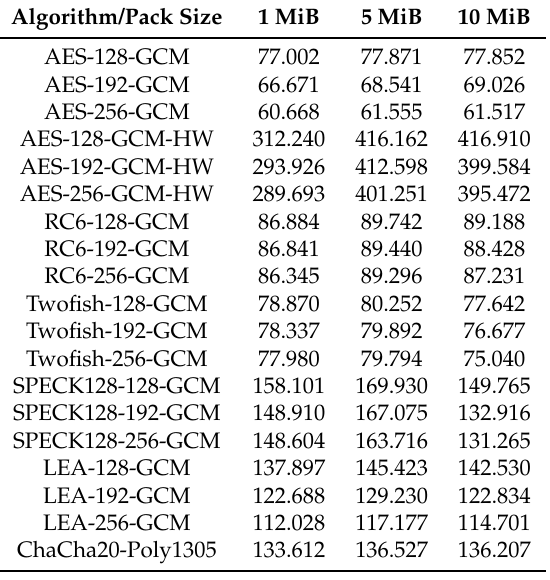
Table A2. Average decryption throughput (MiB/s) in the ARMv8-a Xiaomi